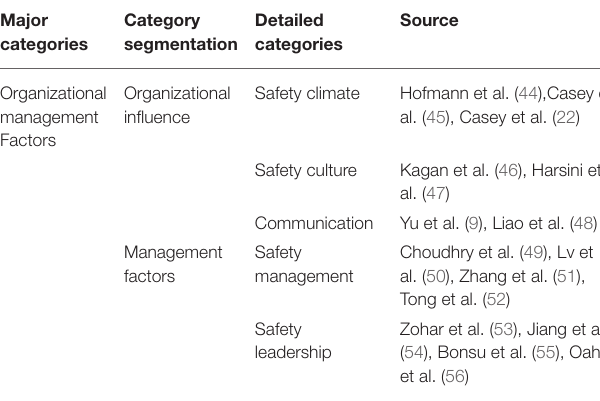
TABLE 4 | Organizational management factors.